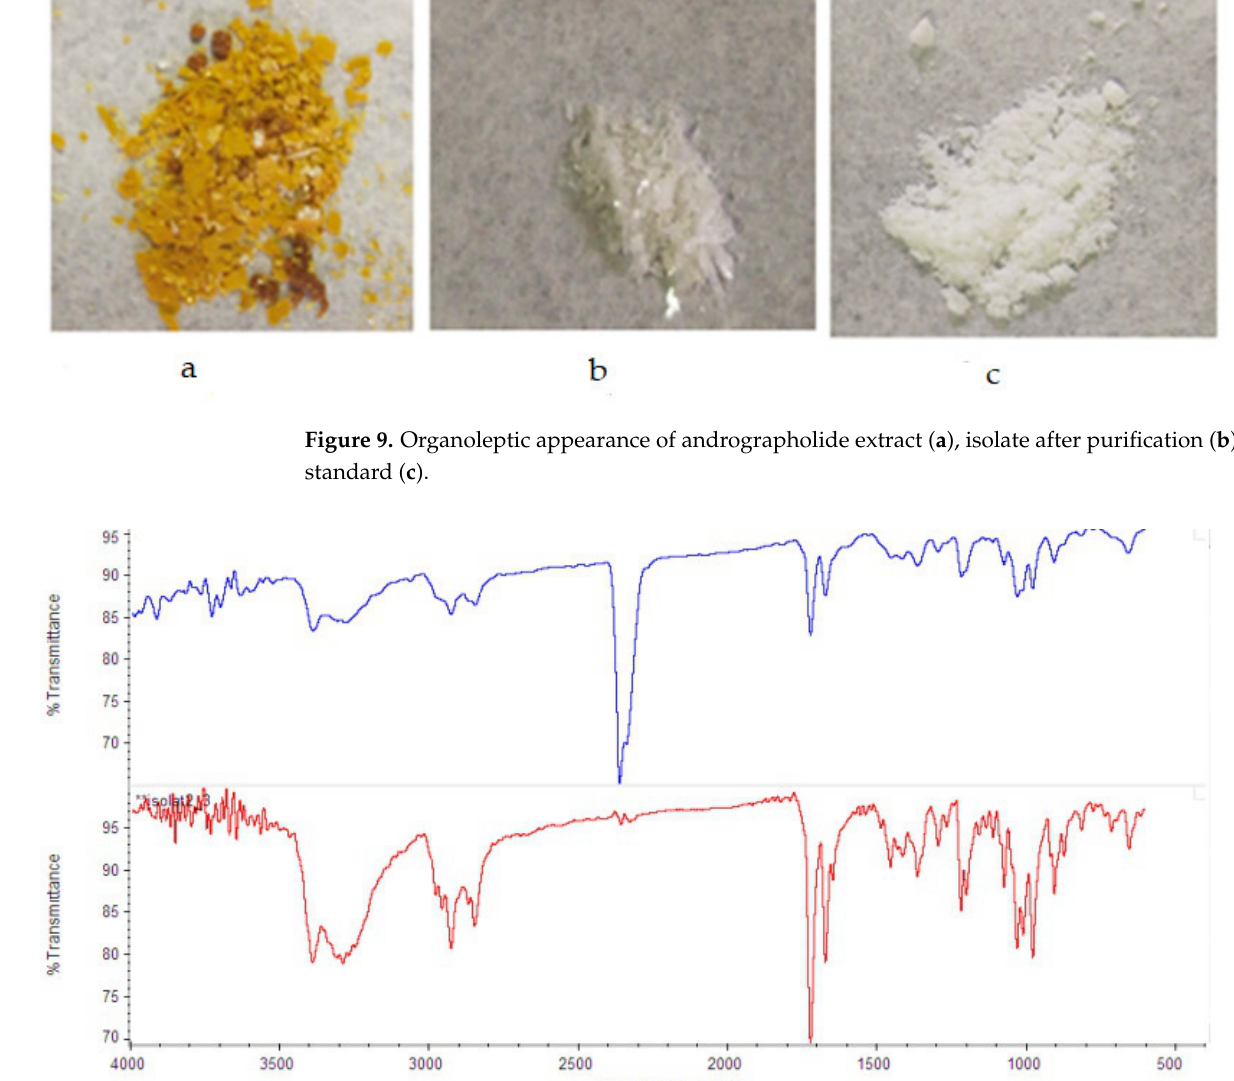
Figure 11. Chromatogram of andrographolide standard (green), isolate (blue), and andro- grapholide extract (red).